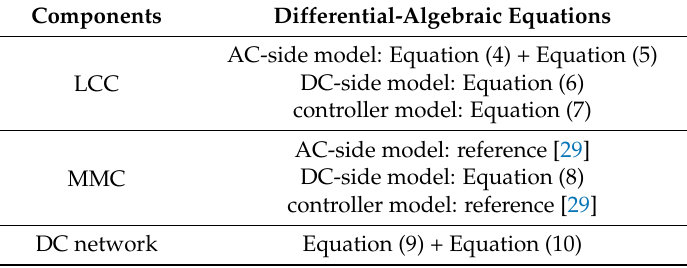
Table 1. Differential-algebraic equations of LCC-MMC hybrid MTDC system.